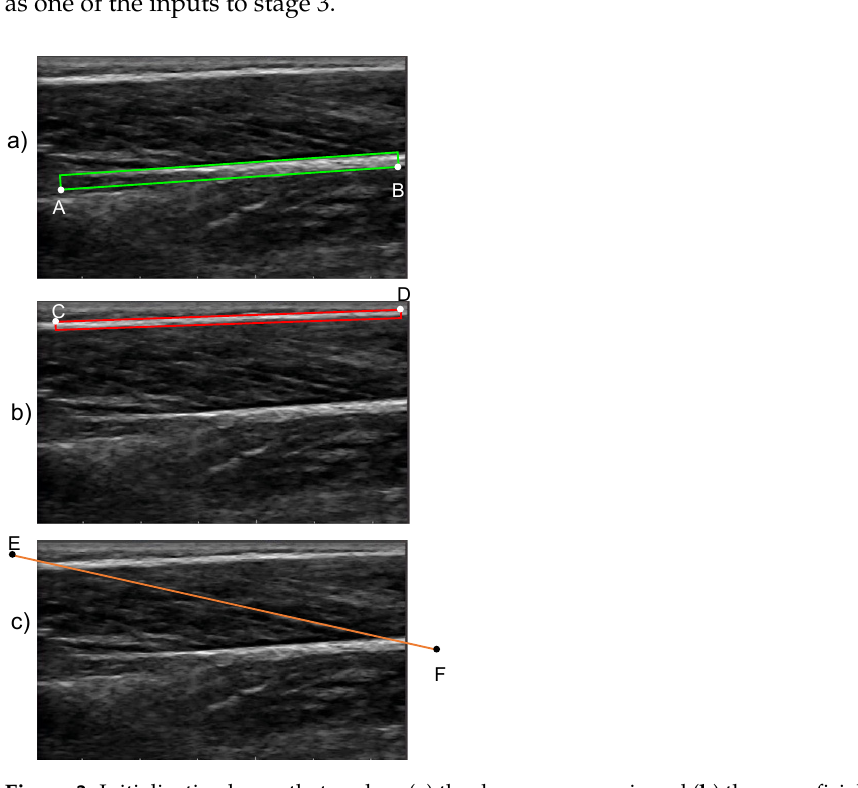
Figure 3. Initialization boxes that enclose ( a ) the deep aponeurosis and ( b ) the superficial aponeurosis. The respective lines that are drawn by the user are denoted as AB and CD for the deep and superficial aponeurosis, respectively. ( c ) The line that is drawn by the user (EF) to initialize the fascicle direction.